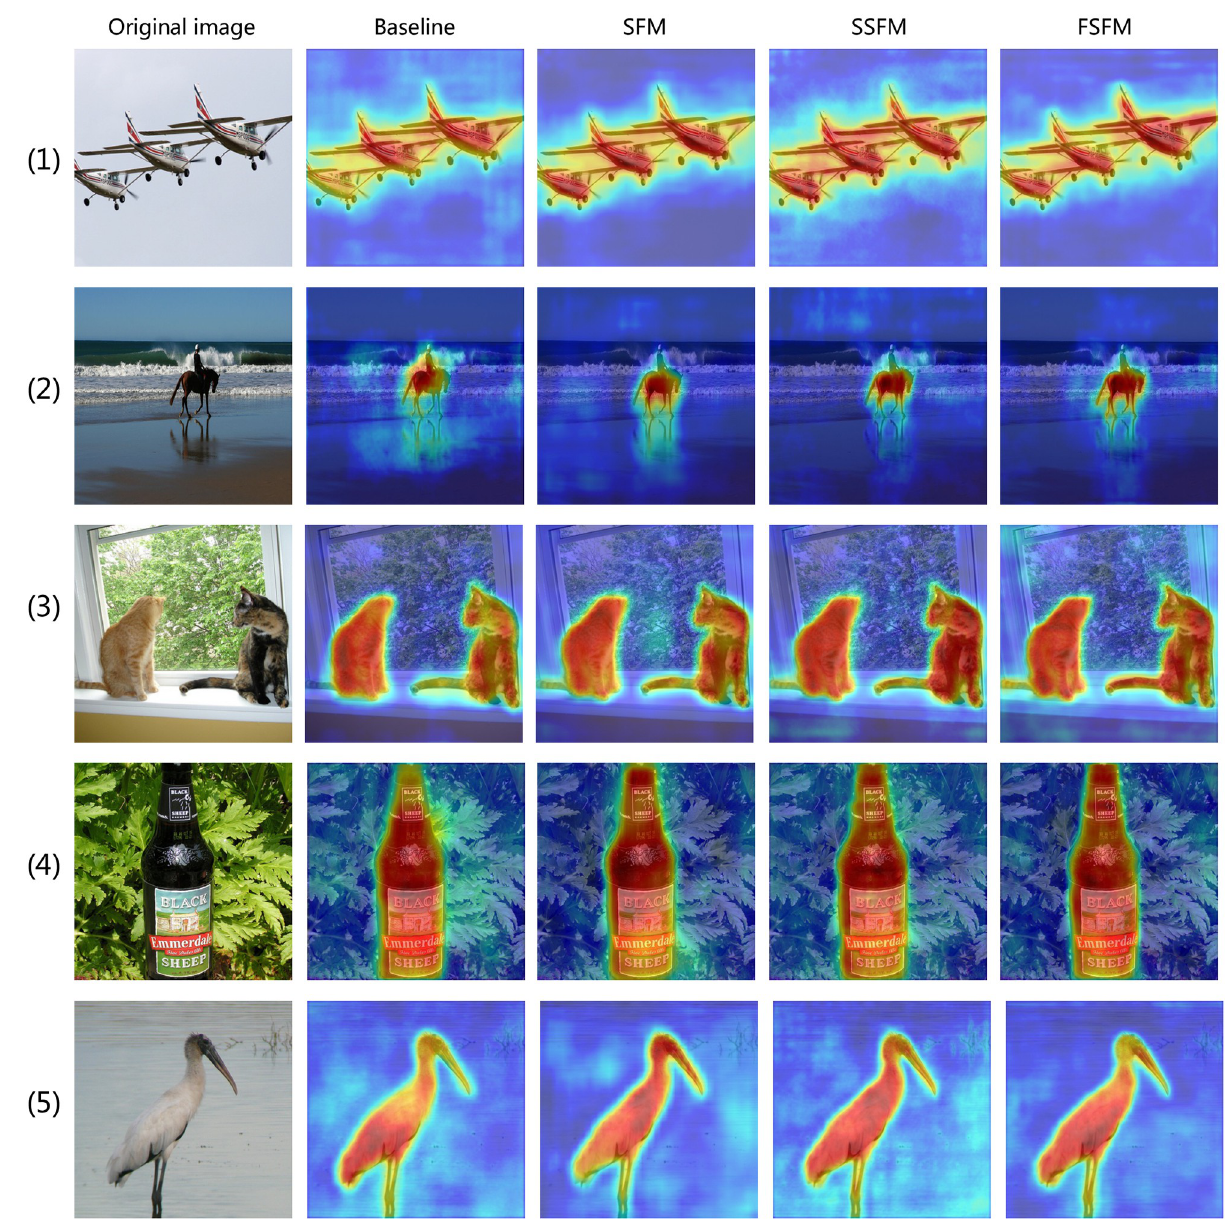
Fig 5. Grad-CAM [45] visualization result and the Grad-CAM visualization are calculated for the last convolutional outputs. The first column is the original image. We compare the visualization results of the proposed three different feature fusion modules with the baseline. Results on Cityscape set. We further examine the generalization ability of the MFEAFN model on the Cityscapes dataset. Four visual examples of the segmentation results of MFEAFN and DeepLabv3+ on the Cityscapes dataset are shown in Fig 8. The first and second columns show the original and labelled images, respectively. The third column shows the segmentation results of DeepLabv3, while the fourth and fifth columns represent the segmentation results when MFEAFN employs ResNeXt 101 and EfficientNetV2 as the backbone networks, respec- tively. For the example image in the first row of Fig 8, the MFEAFN segmentation of the